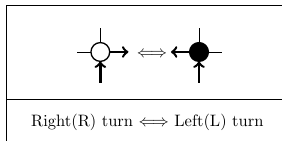
Figure 1. The rule of the ant’s